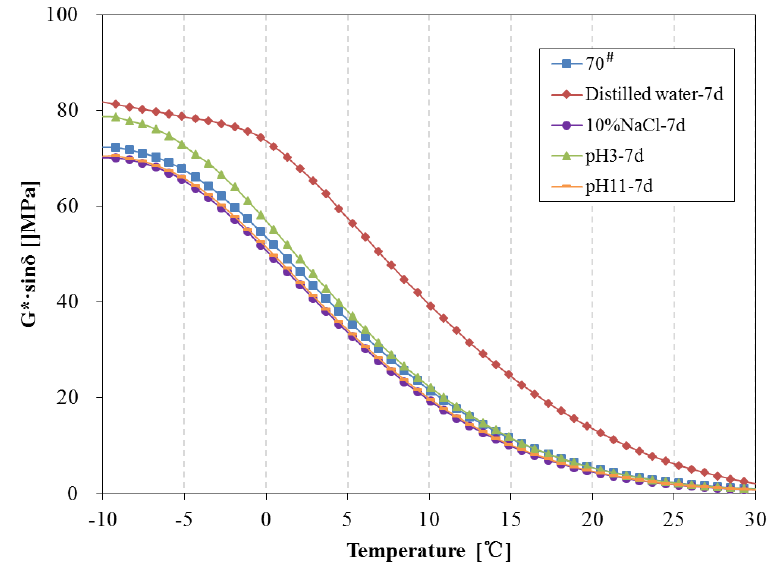
Figure 10. Fatigue factor of 70 # asphalt before and after 7 days immersion.